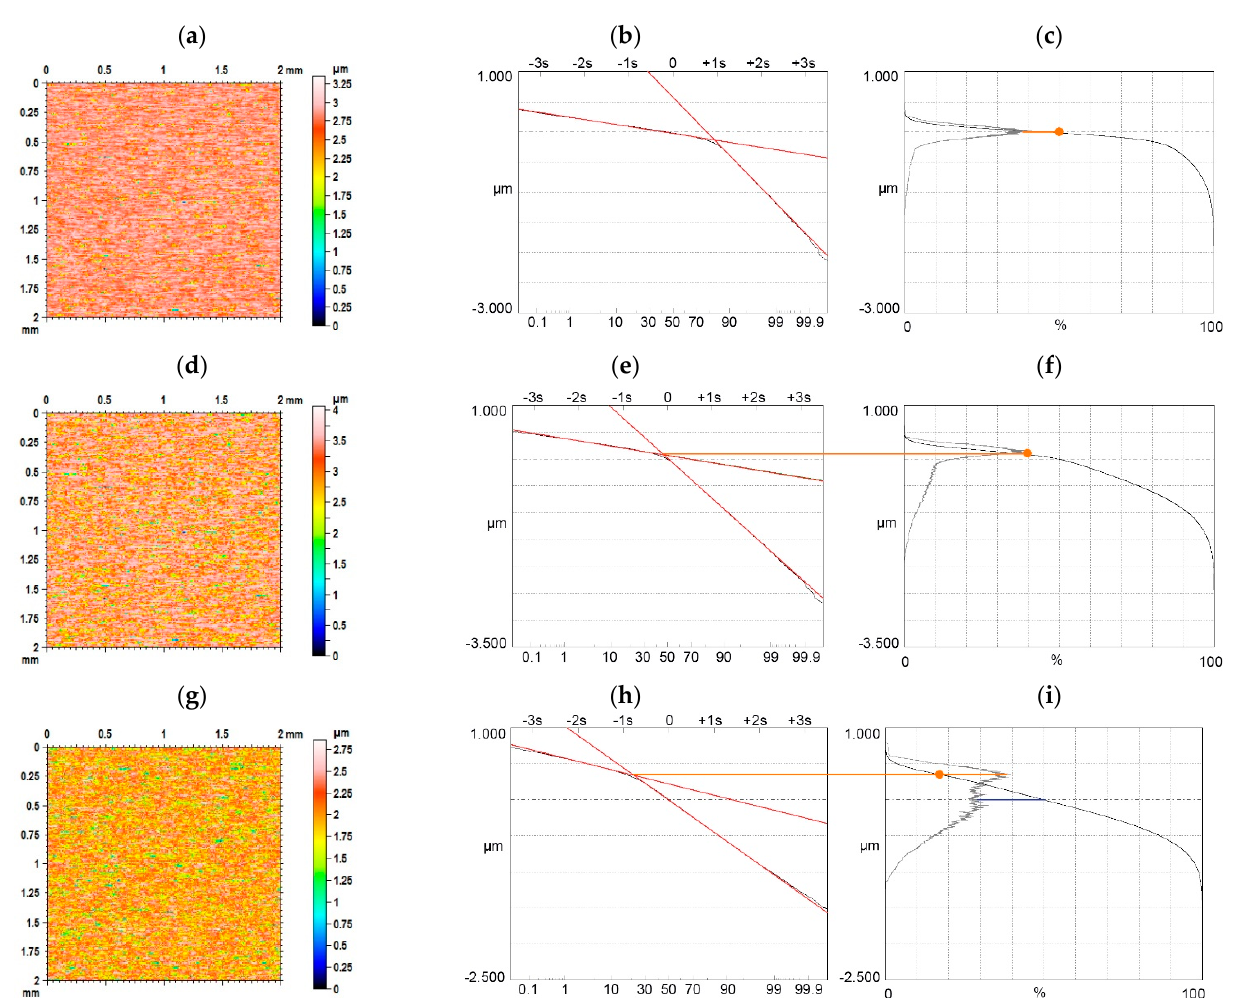
Figure 12. Color-code plot ( a , d , g ) probability plot ( b , e , h ), material ratio curve and probability distribution ( c , f , i ), of random two-process isotropic modeled surfaces of the Smq parameter of 80%, Spq = 0.1 µm, Svq = 0.75 µm ( a – c ), Smq = 40%, Spq = 0.1 µm, Svq = 0.75 µm ( d – f ), and Smq = 20%, Spq = 0.1 µm, Svq = 0.35 µm ( g – i ).